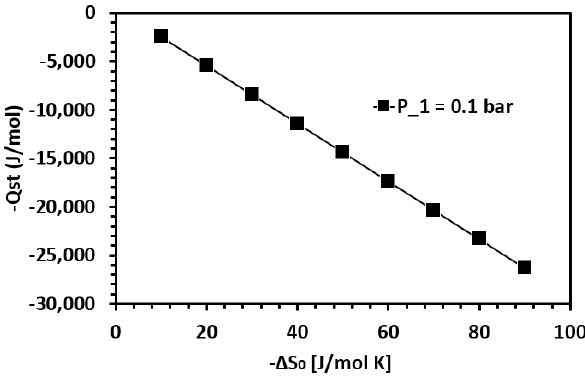
Figure 8. Optimal Qst as a function of the entropy change relative to the standard pressure P 0 (1 bar).